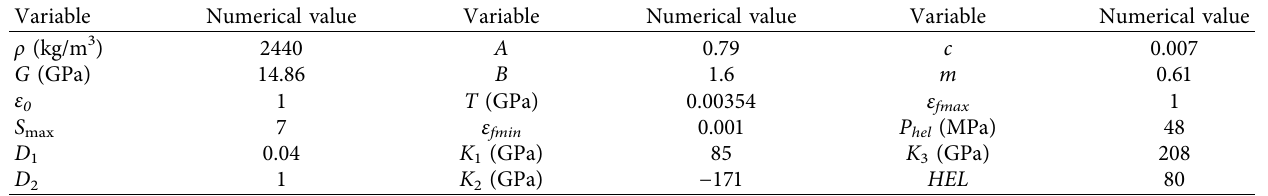
Table 2: JH2 parameters (Holmquist and Johnson 1993).